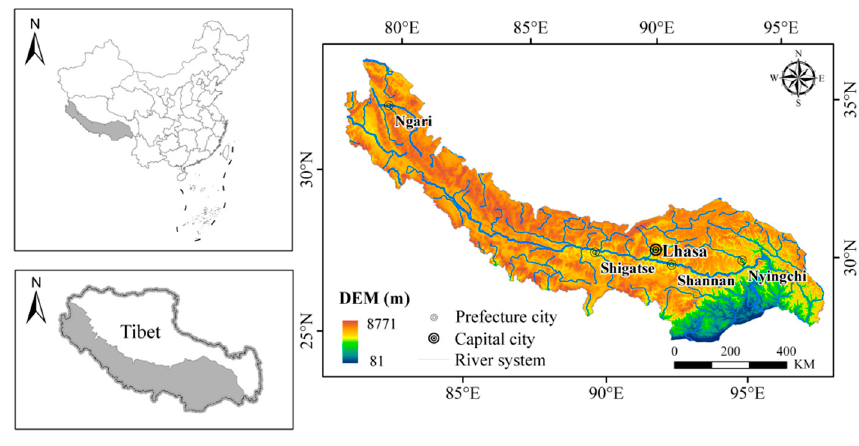
Figure 1. Location of the study area.